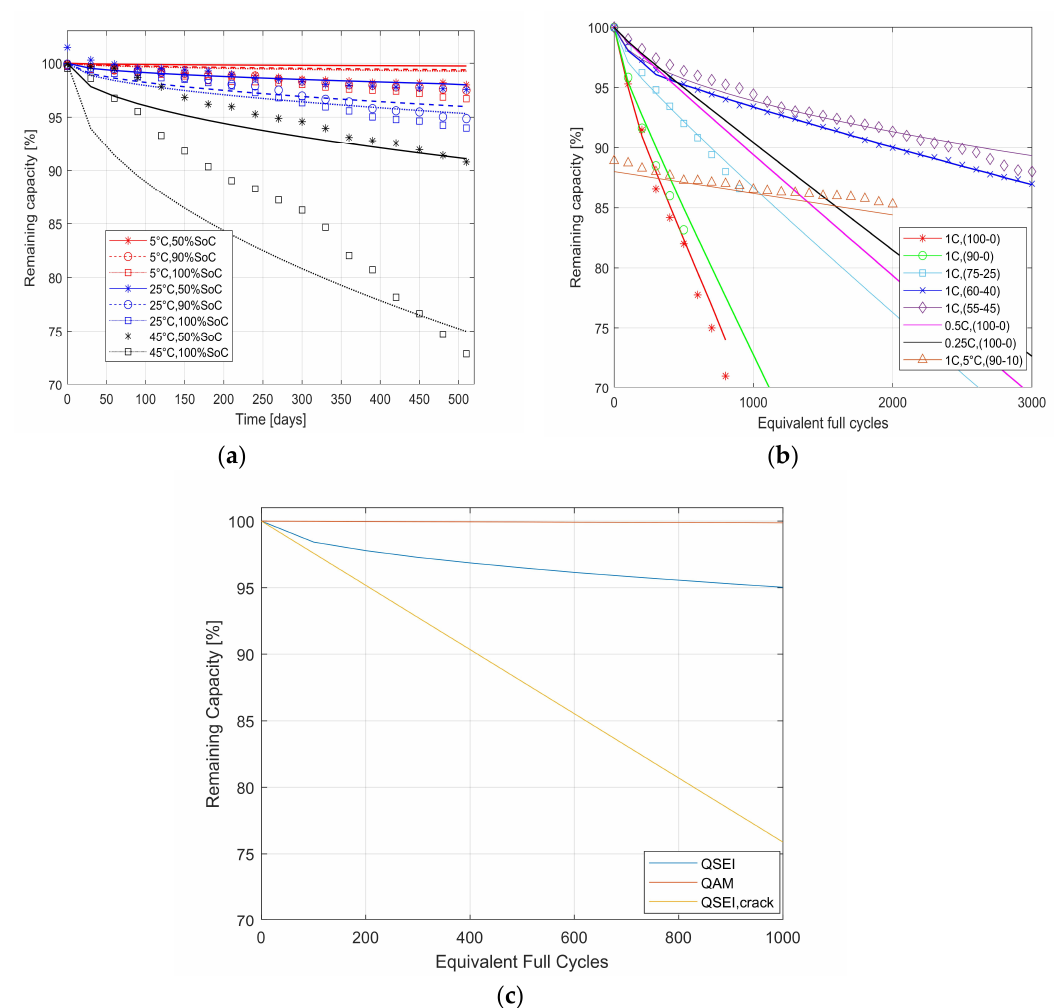
Figure 6. Battery degradation model results (lines) with their experimental data (markers) ( a ): calendar aging results with different temperatures and states of charge with experimental data taken from [77]; ( b ) cycle aging results with different depth of discharge ranges and C-rates at T = 35 °C with experimental data taken from [78], except for the 1C result at 5 °C (90–10) taken from [77]; ( c ) detailed version of 1C (100–0) degradation based on the physics-based degradation model mechanisms.